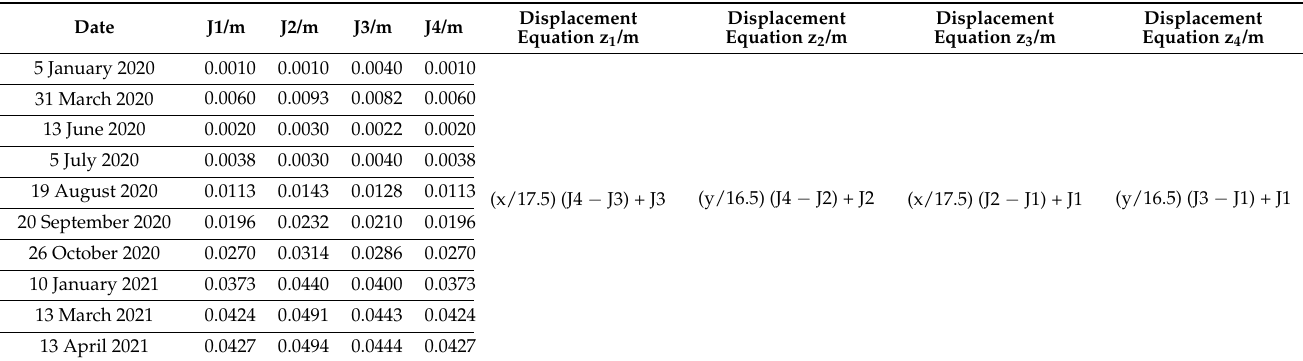
Table 2. Monitoring results of relative displacement at each monitoring point and predefined displacement equation on the bottom frames of the model.